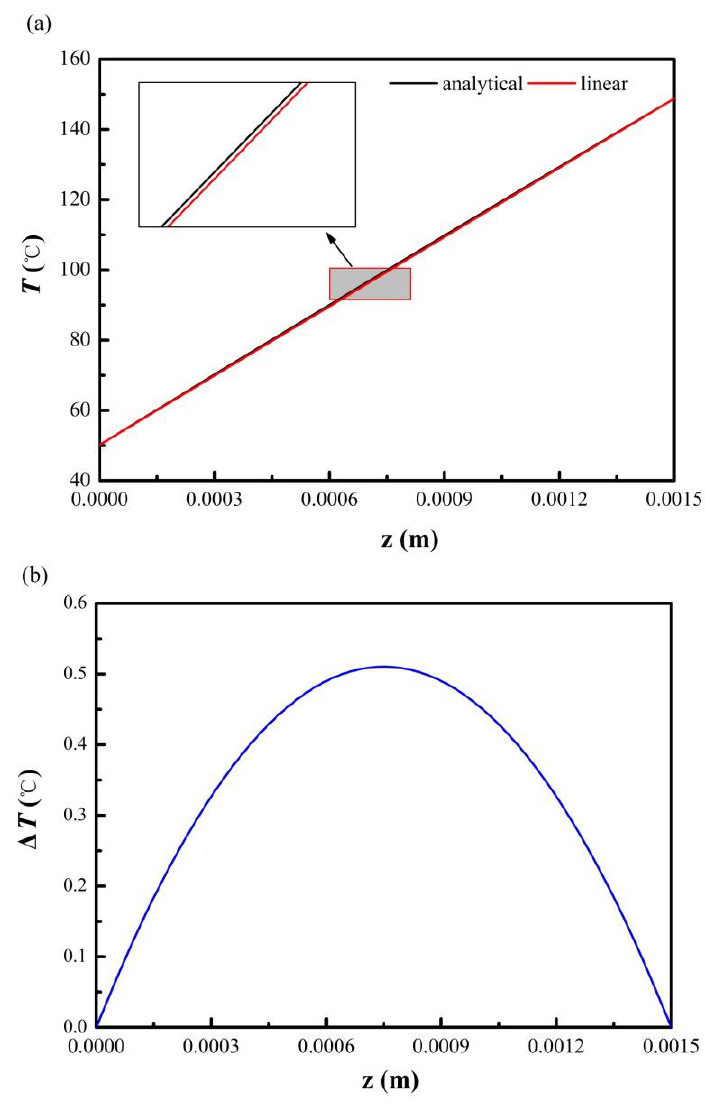
Figure 6. Temperature distribution under the maximum current. ( a ) Temperature distribution along the leg; ( b ) Temperature difference between the analytical temperature and the corresponding linear result along the leg.